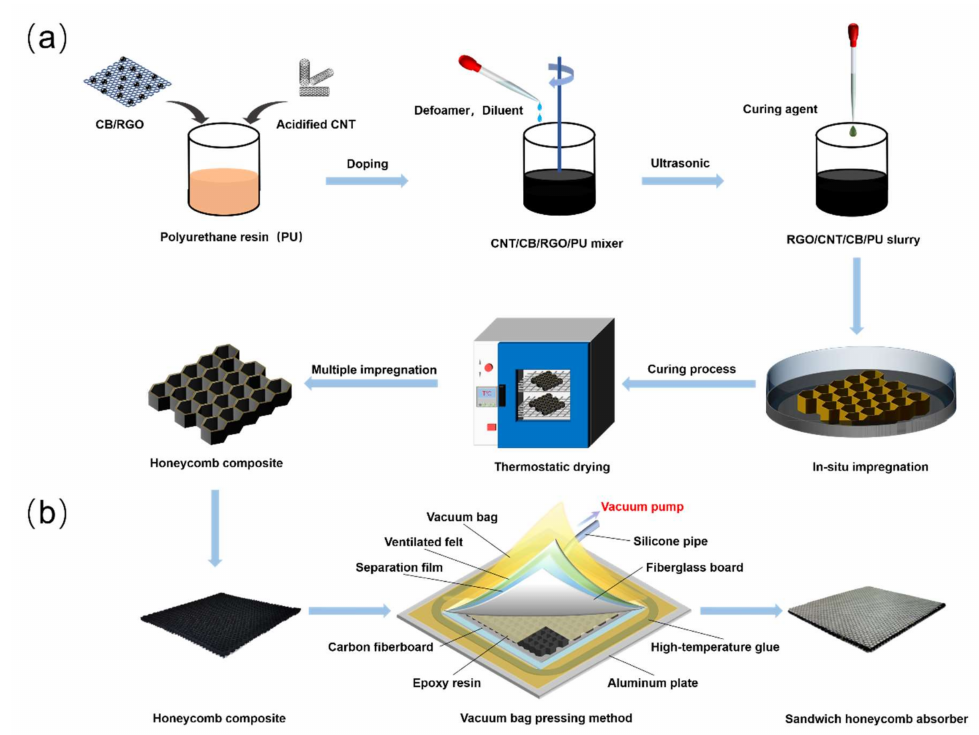
Figure 1. Illustration of ( a ) the HC composite fabrication progress and ( b ) the SHC absorber fabrica- tion progress. Table 1. Stack details and thicknesses of multi-layer CNT/CB/RGO/PU HC composite. Sample Code Thickness Stack Number (from Top to